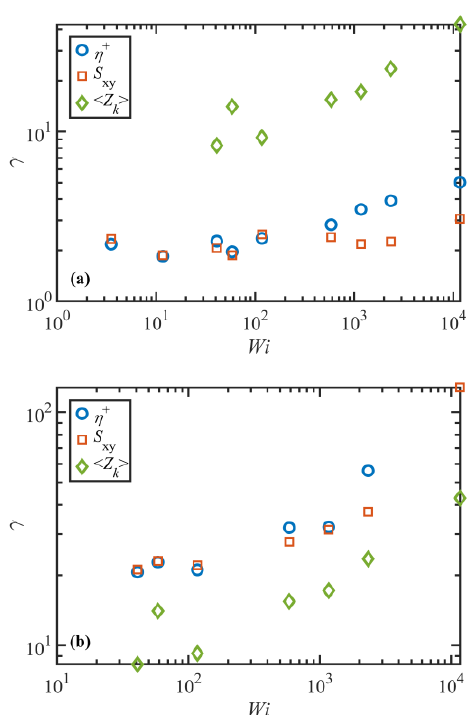
Figure 12. Shear strain, γ , at the times of overshoot ( a ) and undershoot ( b ) in the transient viscosity, η + , and S xy component of the tube orientation tensor, as well as strain at the undershoot time for the entanglement density as a function of Wi in both panels. Note that the undershoot time in (cid:104) Z k (cid:105) does not coincide with either the overshoot or undershoot strain in η + or S xy . The strain overshoots for η + and (cid:104) Z k (cid:105) scale as Wi 0.17 and Wi 0.33 respectively, for Wi > 58 .